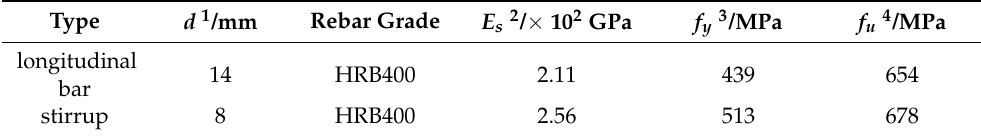
Table 4. Rebar tensile test results.